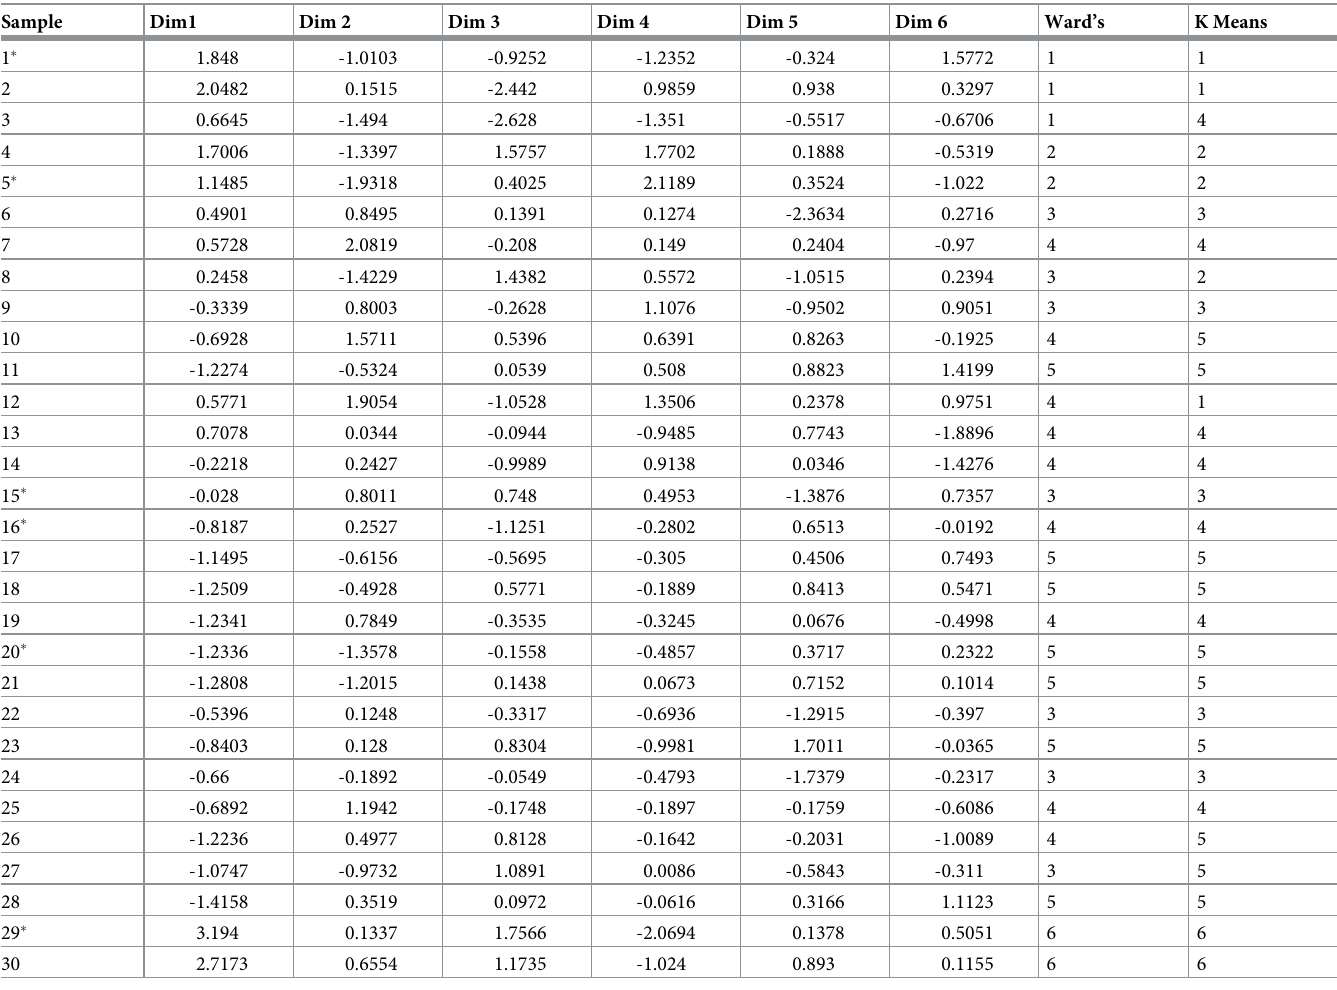
Table 5. Clustering results of picture samples.